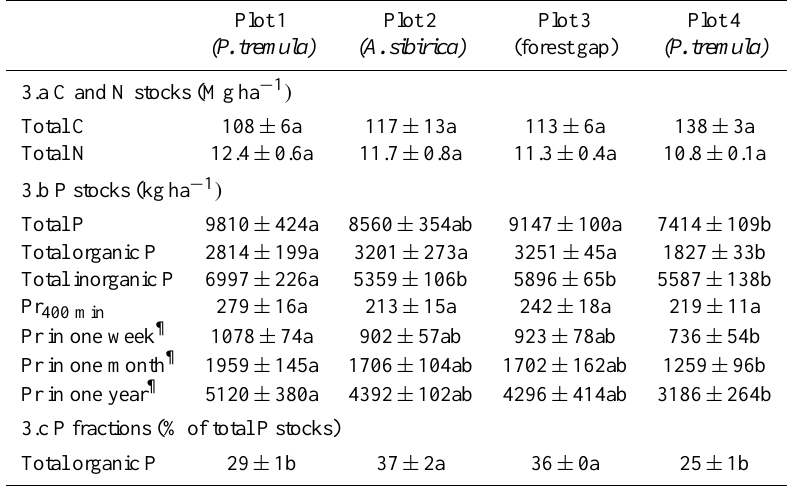
Table 3. Stocks of C, N, and P and P fractions as a % of total P in the entire forest floor + mineral soil profile